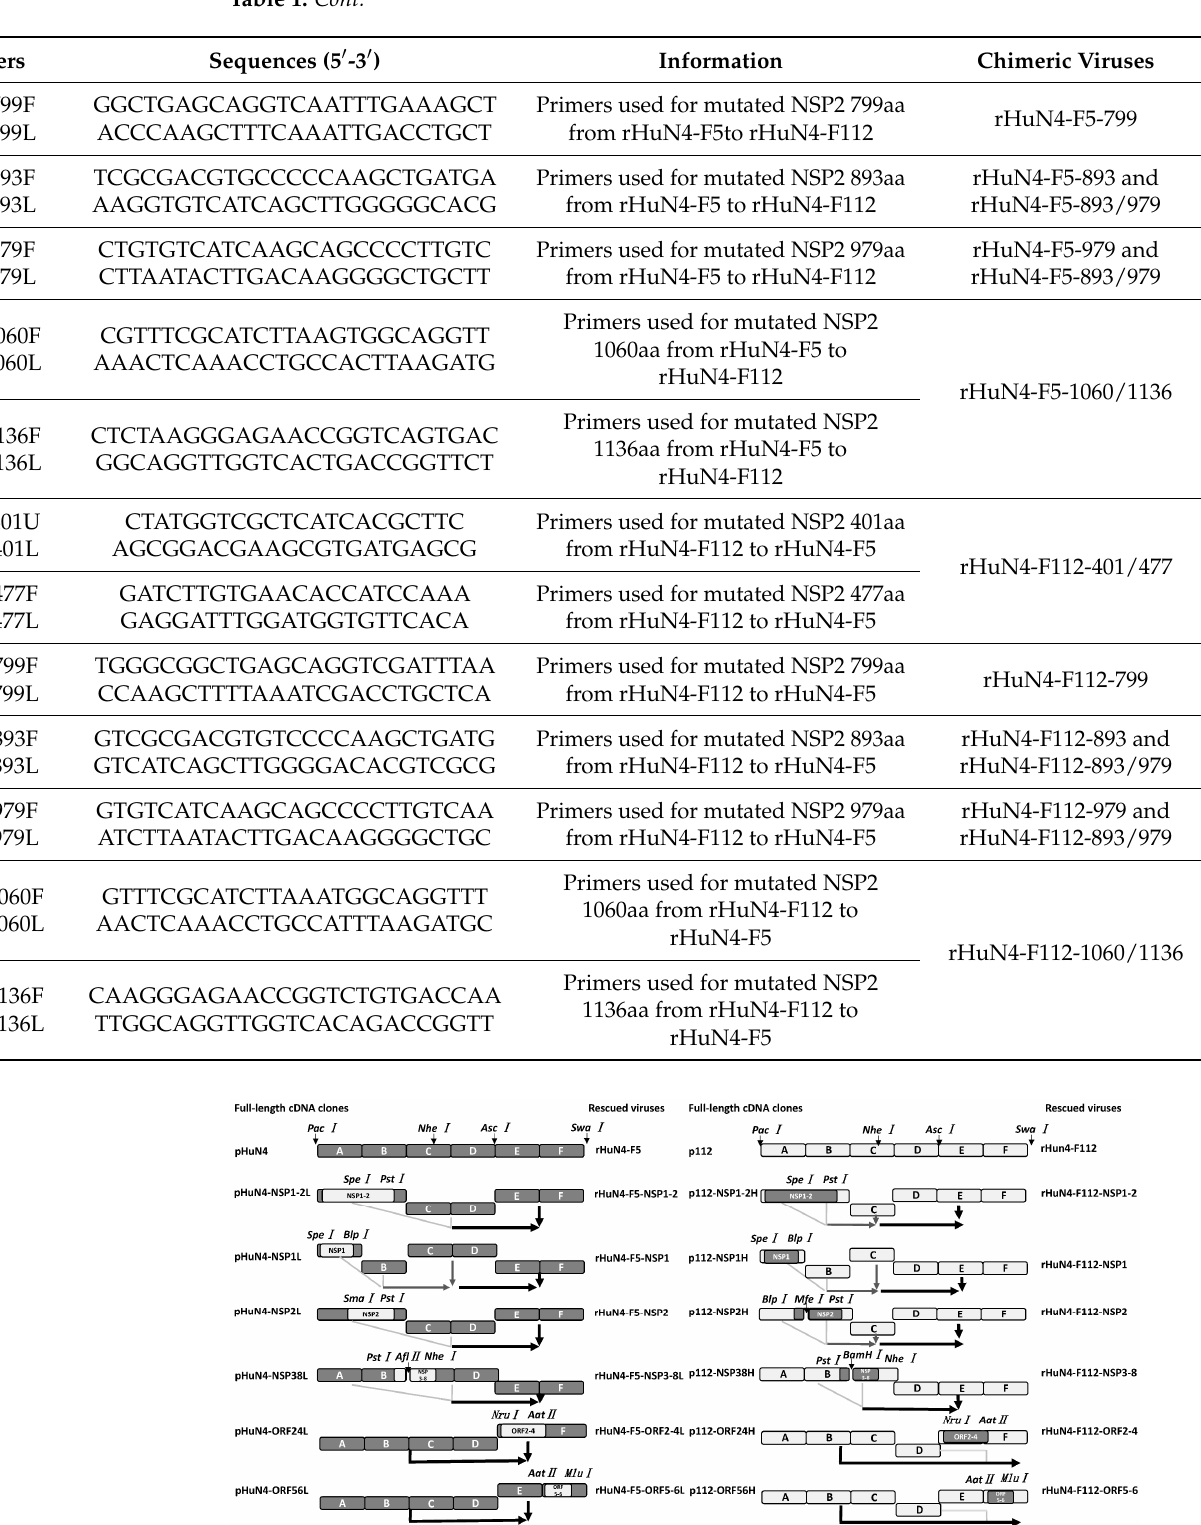
Figure 1. Construction of chimeric PRRS viruses. The PRRSV genome structure of rHuN4-F5 (dark gray) and rHuN4-F112 (light gray) were shown at the top of the figure. Restriction sites used for cloning were set in italics. The full infection clone plasmids were shown on the left and the designation of each chimeric viruses were shown on the right